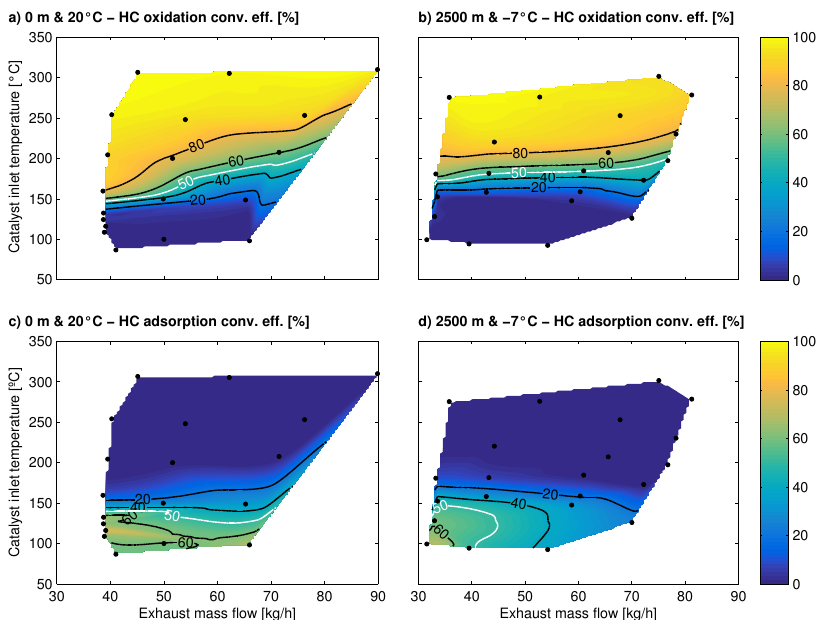
Figure 6. Adsorption and oxidation contributions to HC conversion efficiency as a function of the exhaust mass flow and catalyst inlet temperature: ( a ) oxidation at 0 m and 20 ◦ C; ( b ) oxidation at 2500 m and − 7 ◦ C; ( c ) adsorption at 0 m and 20 ◦ C; and, ( d ) adsorption at 2500 m and − 7 ◦